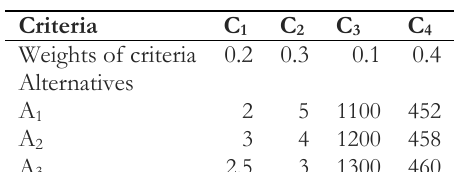
Table 7. Decision matrix